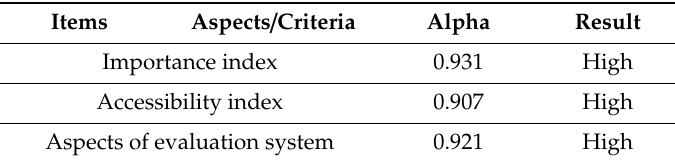
Table 2. The analysis of reliability (Cronbach α ).